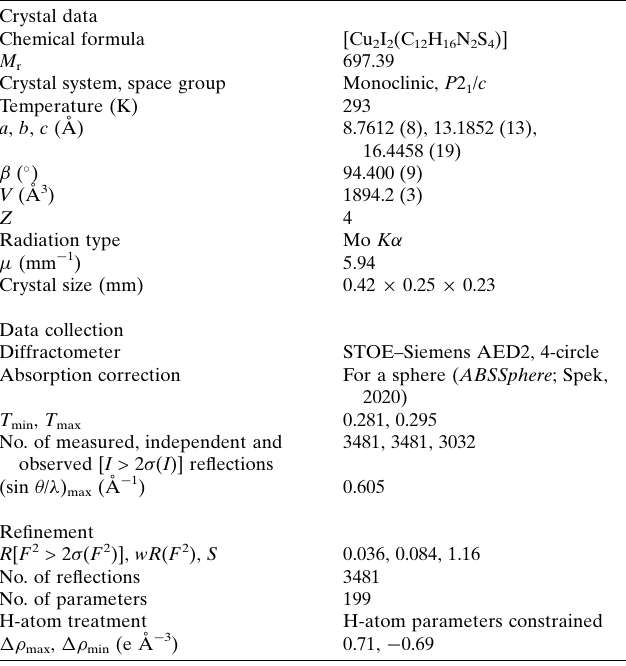
Table 3 Experimental details. Crystal data Chemical